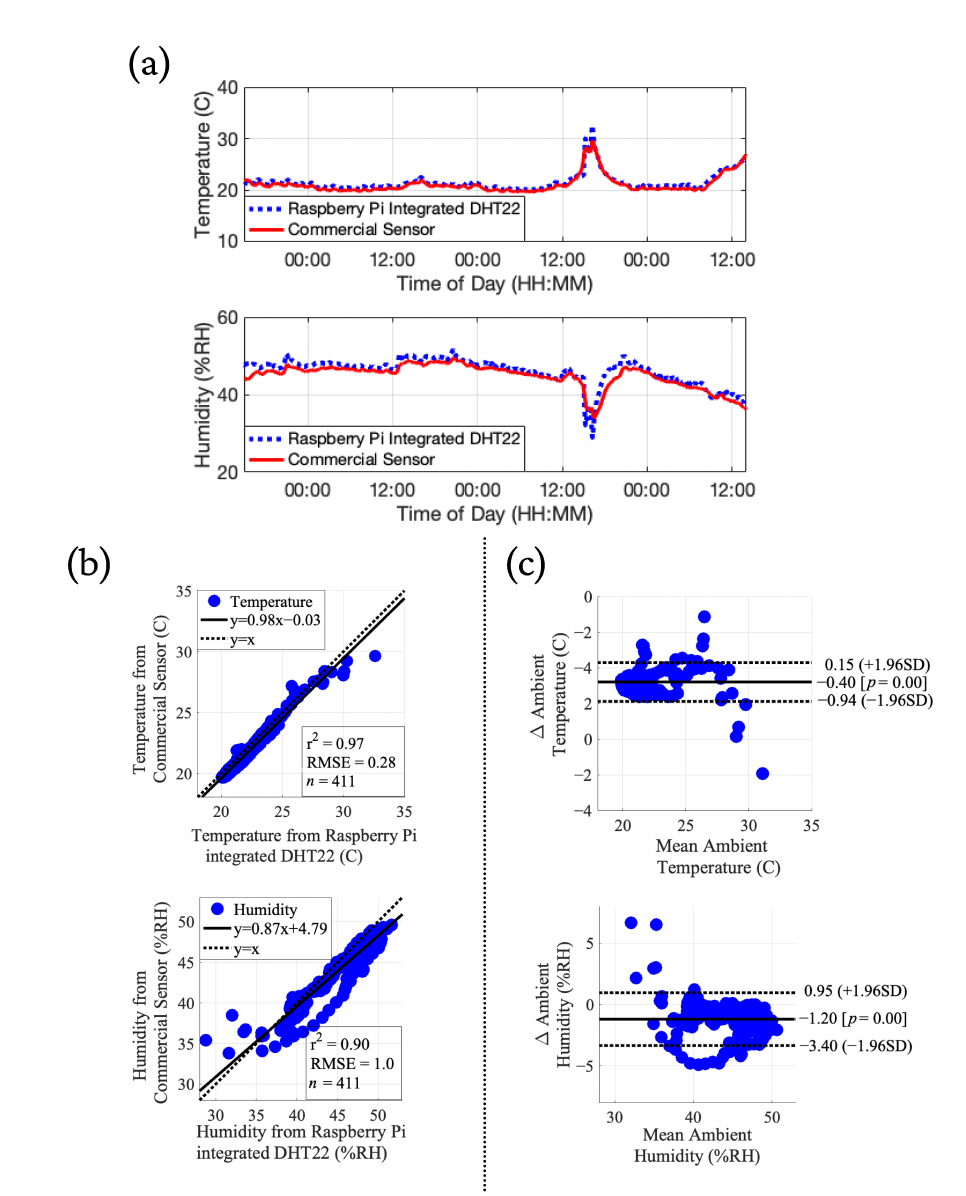
Figure 6. Comparison of temperature and humidity values captured by the Raspberry Pi (RPi) integrated DHT22 sensor and a commercial sensor. The top plot corresponds to temperature in each subplot, and the bottom plot corresponds to humidity values. ( a ) The dashed blue lines indicate the processed temperature and humidity values captured by the RPi integrated DHT22 sensor. The solid red lines indicate the corresponding values captured by the commercial sensor. ( b ) The correlation plots between values captured from the DHT22 sensor and the commercial sensor. The solid-blue circles ( ) indicate individual temperature and humidity tuples. The linear fits on the data and their deviations from the 45 ◦ line are depicted in the plot. ( c ) The Bland-Altman plot between the two measurements. The solid black lines indicate the mean difference between the two measurements. The dashed black lines indicate the +1.96 and the − 1.96 standard deviation (SD) lines for the difference between the two